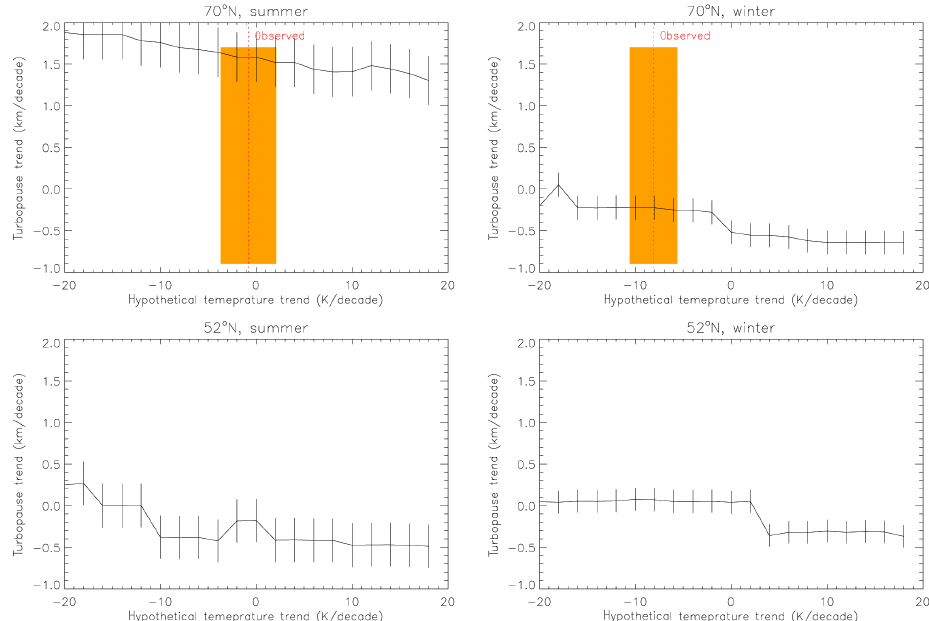
Figure 3. Response of turbopause trend line to different upper-mesosphere/lower-thermosphere temperature trends. Hypothetical trends range from an unrealistic cooling of 20Kdecade − 1 to a similarly unrealistic warming. Top left: 70 ◦ N summer (average of May, June and July); top right: 70 ◦ N winter (average of November, December and January); bottom left: 52 ◦ N summer; bottom right: 52 ◦ N winter. Observed values for 70 ◦ N are also identified on the upper panels (dashed vertical lines) together with uncertainties